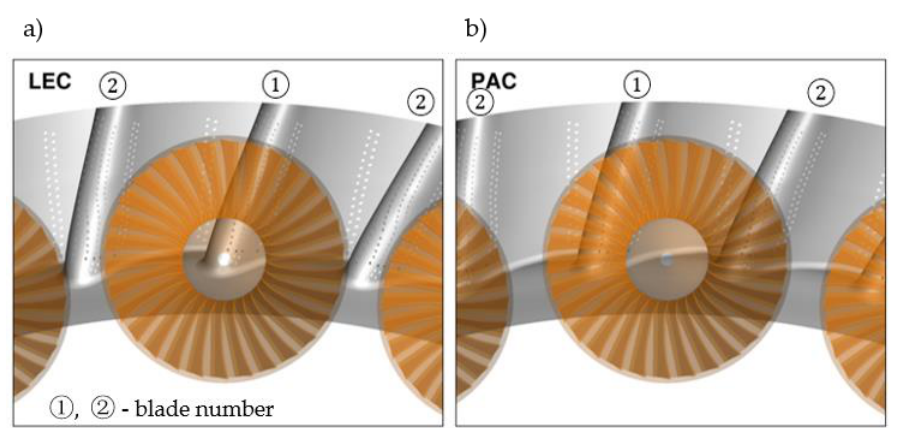
Figure 3. Swirler and NVG relative position: leading edge clocking (LEC—( a )) and passage clocking (PAC—( b )).